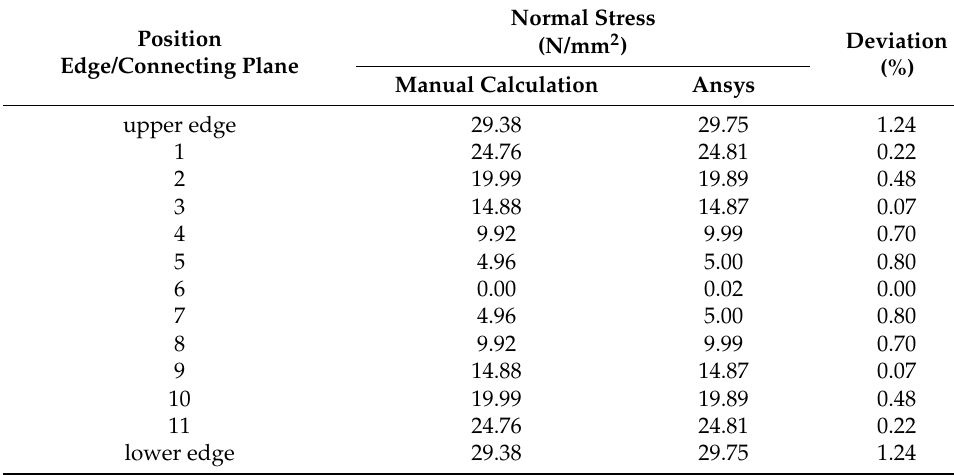
Figure 32. Shear Stress. Table 4. Comparison of normal stresses between experimental tests and